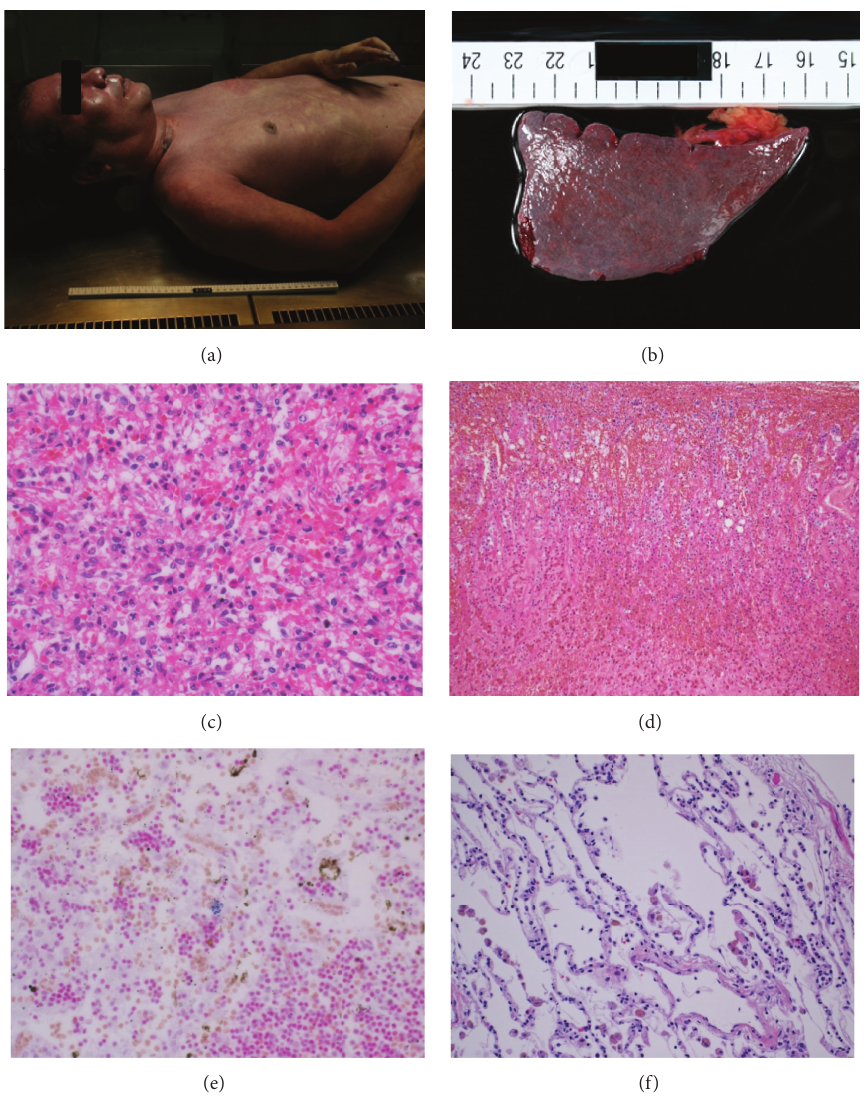
Figure 2: Autopsy analysis. (a) Gross inspection of the entire body revealed purpura fulminans in the face, neck, and chest. (b) Macroscopic analysis of the spleen. The spleen weighted 20 g, with a size of 7.5 × 4.0 × 1.8cm. (c) Microscopic analysis of the spleen revealed striking neutrophil infiltration. This finding was compatible with acute splenitis, showing evidence of sepsis. (d) Microscopic analysis of the adrenal glands demonstrated hemorrhage in all the layers of the cortex and medulla. Hemosiderin dispositions are apparent. (e, f) Microscopic analysis of the tonsils (e) and lungs (f) revealed streptococci (gram